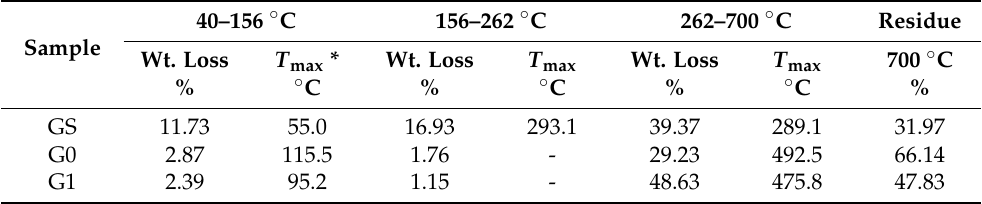
Table 2. The weight loss (Wt. loss) and maximum decomposition temperature ( T max ) of SiO